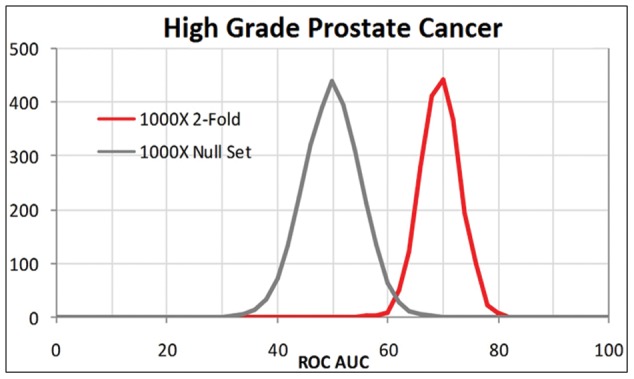
PCR data from a sample set of 122 PAXgene samples of prostate cancer from the G8 group and 138 PAXgene samples from the control group were performed in a 1000×2-fold cross-validation test.Histograms of AUC were plotted and compared; results showed AUCs from the PCR data were well separated from the null sets, with an overlap of less than 5%.